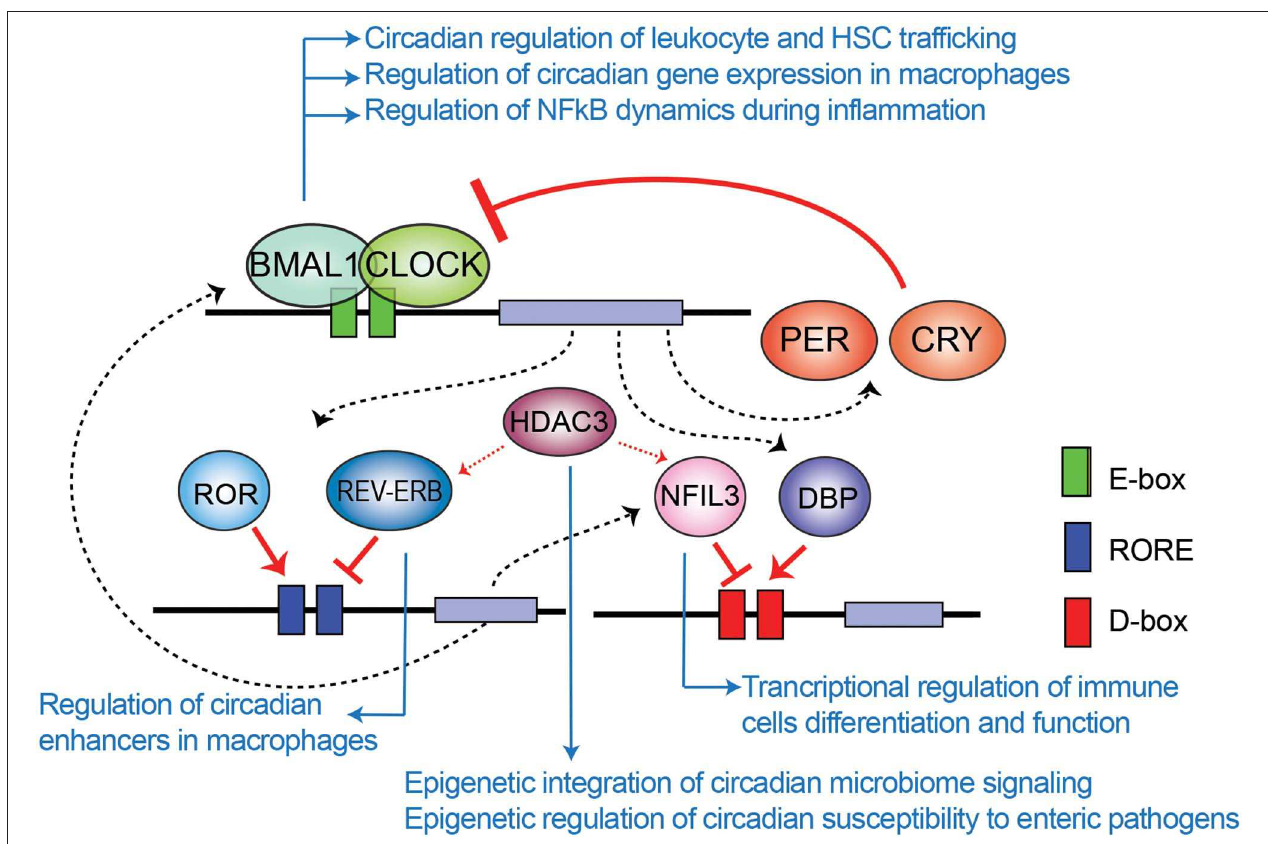
FIGURE 1 | Transcriptional-translational feedback loops control circadian gene expression. Rhythmic binding to e-boxes on chromatin of the clock components of the positive loop, CLOCK:BMAL1, induce the expression of clock-controlled genes and the clock negative regulators PER and CRY. Additionally, the nuclear receptor REV-ERB α and ROR impose transcriptional rhythms on genes via RORE cis regulatory elements, while the PAR-bZIP transcription factors DBP, and the repressor NFIL3 interplay to drive transcriptional rhythms in a set of genes through binding to D-boxes. Blue arrows relate molecular components of the clock TTFL involved in epigenetic regulation of the indicated mechanisms of immunity and infection, which are further discussed across the